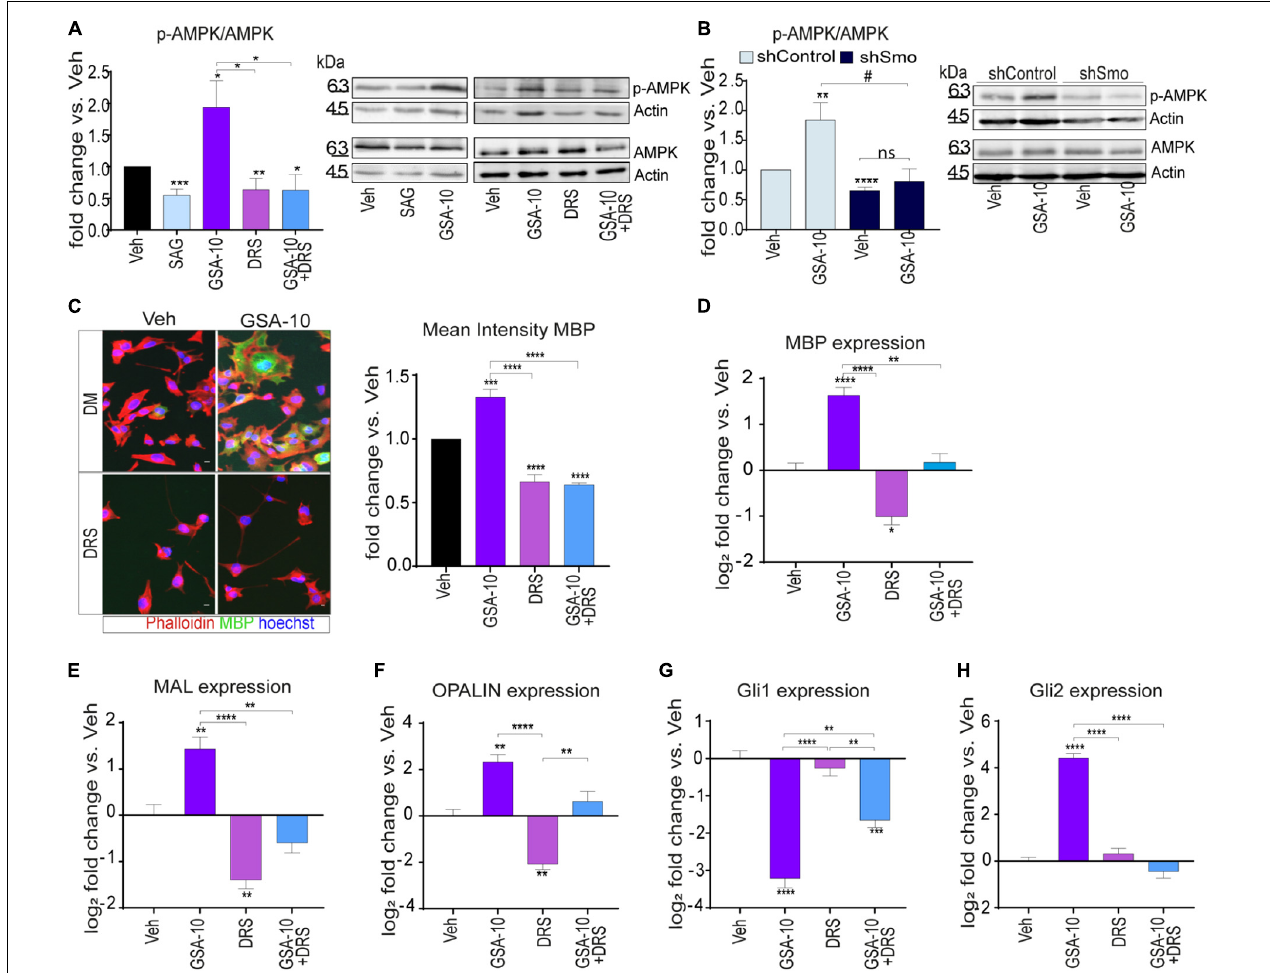
FIGURE 5 | AMPK signaling is required for Oli-neuM differentiation and Gli2 gene expression. (A) Immunoblot analysis of Oli-neuM cell extracts after treatment with 5 µ M SAG, 10 µ M GSA-10, 3 µ M Dorsomorphin (DRS), or alone or in combination with GSA-10. Left panel: Quantitative analysis of protein levels: anti-AMPK (AMPK) or phospho-AMPK (pAMPK) antibody. Anti-actin antibody was used to normalize sample loading ( n ≥ 3). Signal intensity was estimated using ImageJ software tools, and values ± SEM were plotted as the fold change of p-AMPK/AMPK. Right panel: representative image of immunoblots used for quantitative analysis. (B) Immunoblot analysis of shSmo vs. shControl extracts after treatment with 10 µ M GSA-10 or vehicle. Left panel: Quantitative analysis of protein levels: anti-AMPK (AMPK) or phospho-AMPK (pAMPK) antibody. Quantification was performed as in panel (A) . Values ± SEM ( n ≥ 3) were plotted as the fold change of p-AMPK/AMPK. Right panel: representative image of immunoblots used for quantitative analysis. (C) Quantitative IF images analysis of MBP in Oli-neuM. Left panel: Typical treated cell images, stained with anti-MBP primary and Alexa 488 secondary antibodies (green); Phalloidin (red); Hoechst (blue) = nuclei. Scale bar = 10 µ m. Right panel: Mean FITC (MBP) intensity was plotted as mean ± SEM ( n ≥ 3). Data were normalized with respect to vehicle, arbitrarily set to 1, and plotted as fold induction versus vehicle. (D–H) Quantitative RT-PCR analysis of MBP, MAL, OPALIN, Gli1, and Gli2 expression under GSA-10, DRS, or their combination. Values ± SEM ( n ≥ 3) were plotted as log2 fold change vs. vehicle (which is equal to 0). Statistical significance: two-tailed Student’s t -test was performed for treatment vs. vehicle (vs. shControl in panel (B) ), ANOVA one-way with Tukey’s multiple comparison test was performed to determine significance among different treatments. * p < 0.05, ** p < 0.01, *** p < 0.001, and **** p < 0.0001; # p < 0.05; ns, non